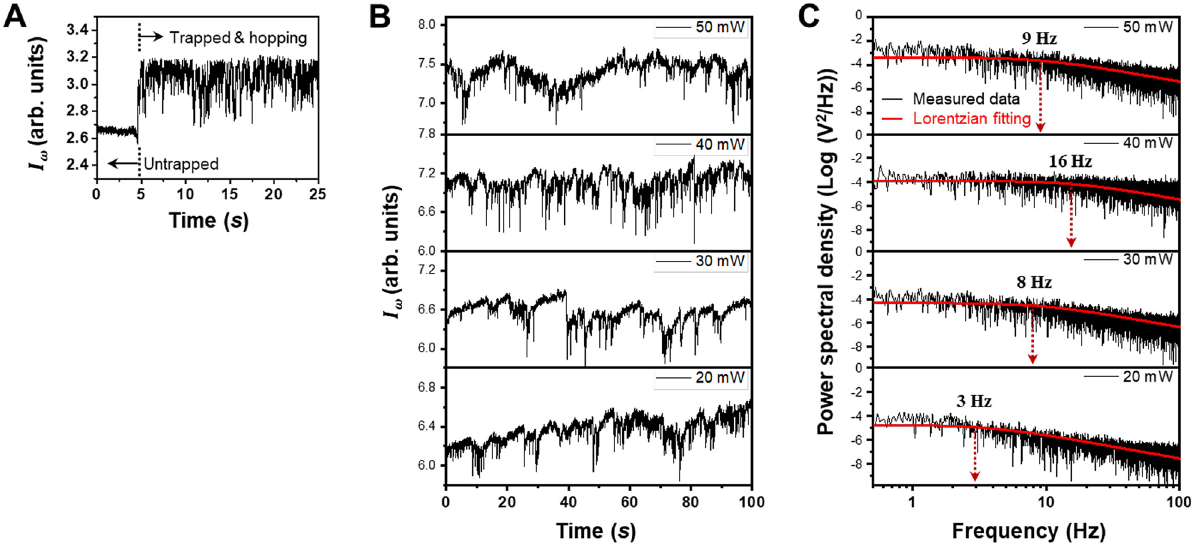
Figure 3: Modulation of quantum dot (QD) hopping rate with different input power. (A) Transmitted signal intensity ( I ω ) of incident lasers before and after the trapping of a 4-nm-diameter QD in a 5-nm-gap nanoantenna. A trapped QD increased the average transmittance, and each hopping event made a sharp spike. (B) Measured I ω when the continuous wave (CW)laserpower( P CW )was20,30,40,and50mWwiththefemtosecondlaserpowerof4mW.(C)Powerspectraofthemeasuredsignals(black dots) and Lorentzian fi tting curves (red lines). When P CW increased from 20 to 40 mW, the roll-off frequencies were measured to be 3, 8, and 16 Hz, respectively. When P CW was 50 mW, the transition rate decreased to 9